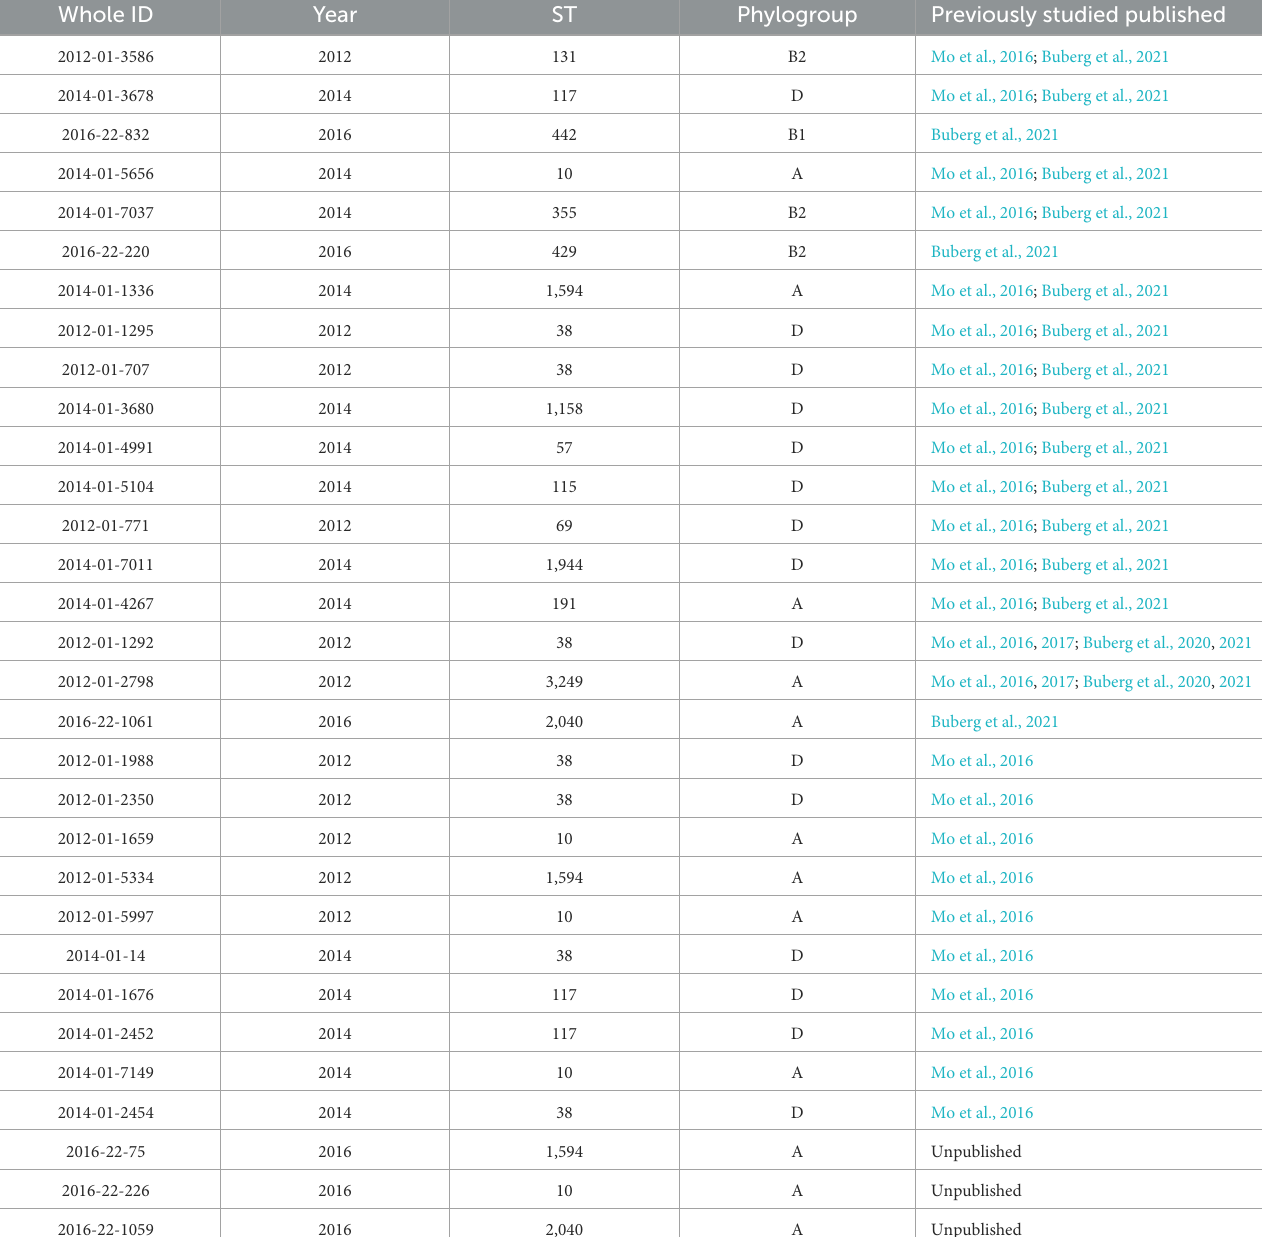
TABLE 1 Isolates included in the